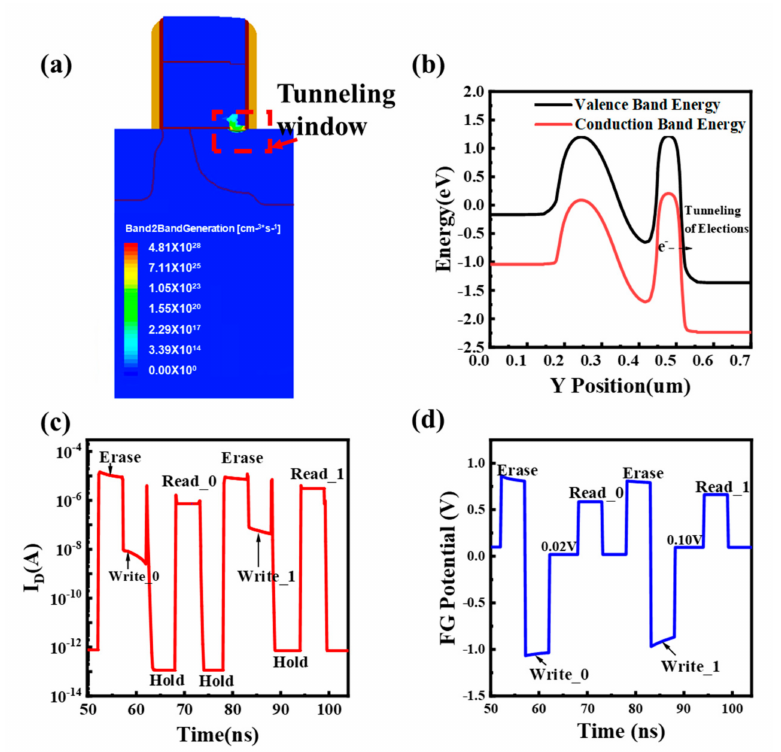
Figure 4. ( a ) The BTBT rate profile and ( b ) bandgap during writing-1 operation. The tunneling generation rate is highest where the band bending is largest. ( c ) The normalized reading and writing operation currents of the HDM. ( d ) The FG potential with the change in the erase-write 0-read-erase-write 1-read operations of the